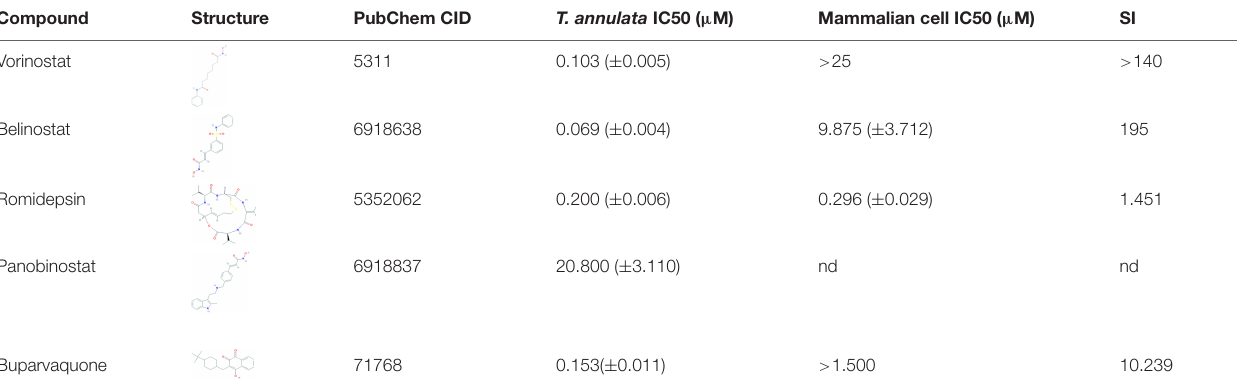
TABLE 1 | In vitro antitheilerial activity of histone deacetylase (HDAC) inhibitors against T. annulata infected cells. Compound